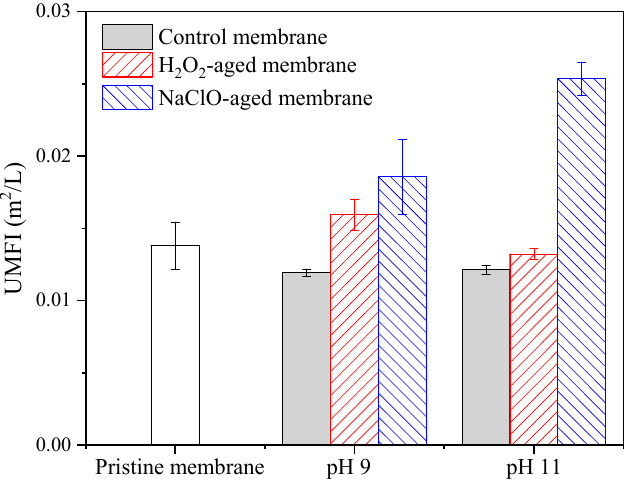
Figure 2. Effects of H 2 O 2 and NaClO aging on fouling behavior of PES membrane during filtration of humic acid (HA) solution. Control membrane indicates membrane samples aged in NaOH solution with pH 9 or 11, c(H 2 O 2 ) = c(NaClO) = 5000 mg/L, t = 100 h, and error bars indicate standard deviation of triplicate samples.